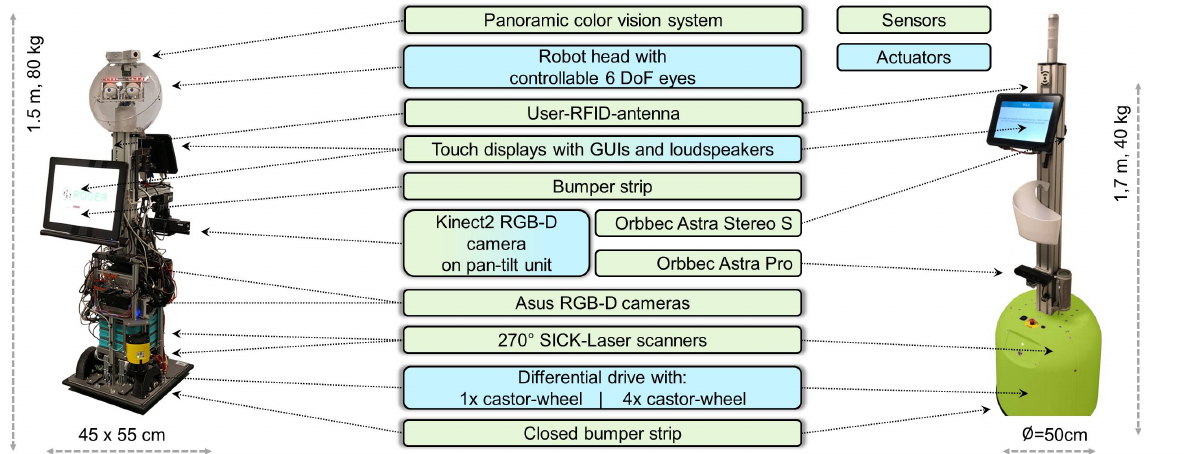
Figure 2. Sensors and hardware of the research platform ( left ) and product prototype platform ( right